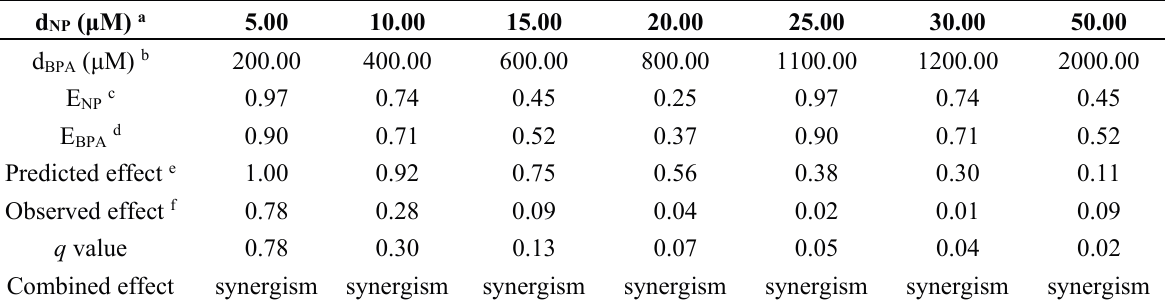
Table 4. Predicted and observed effects of the mixture of nonylphenol (NP) and bisphenol A (BPA) on viability of RWPE-1 cells from the Bliss independence (BI) model.